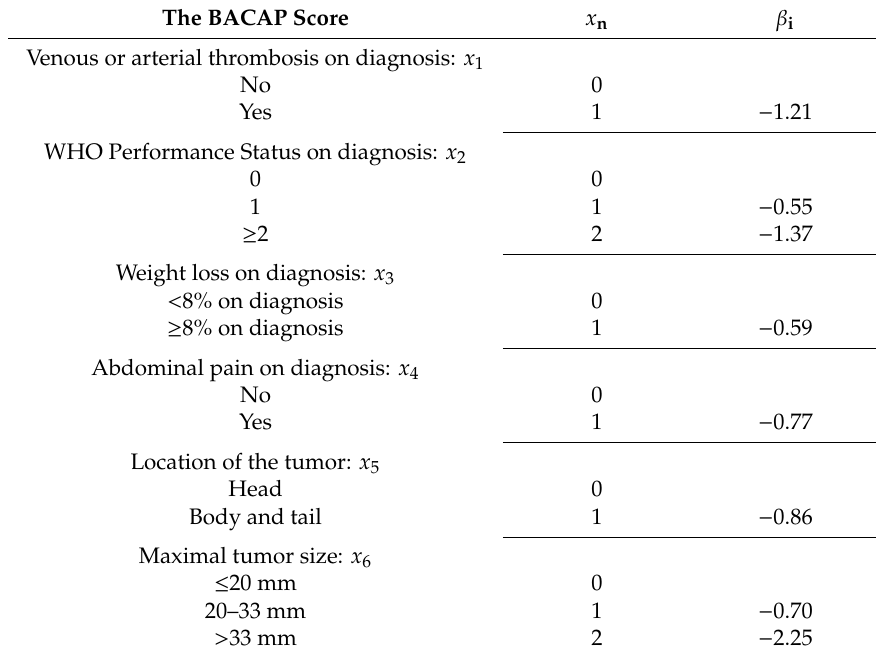
Table 3. The BACAP score: the scoring system to determine the resectability of pancreatic ductal adenocarcinoma. Exp: exponential